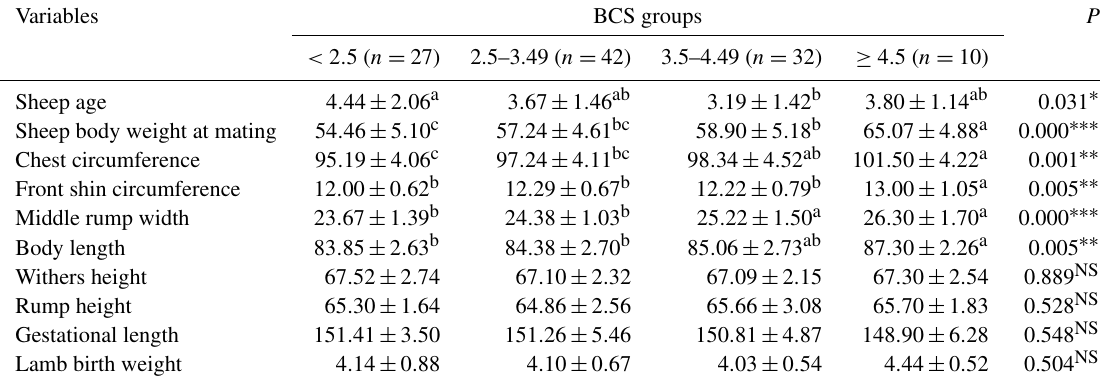
Table 2. Descriptive statistics and comparison results for breeding season variables in terms of the four BCS groups. The results are given as the mean ± SD (standard